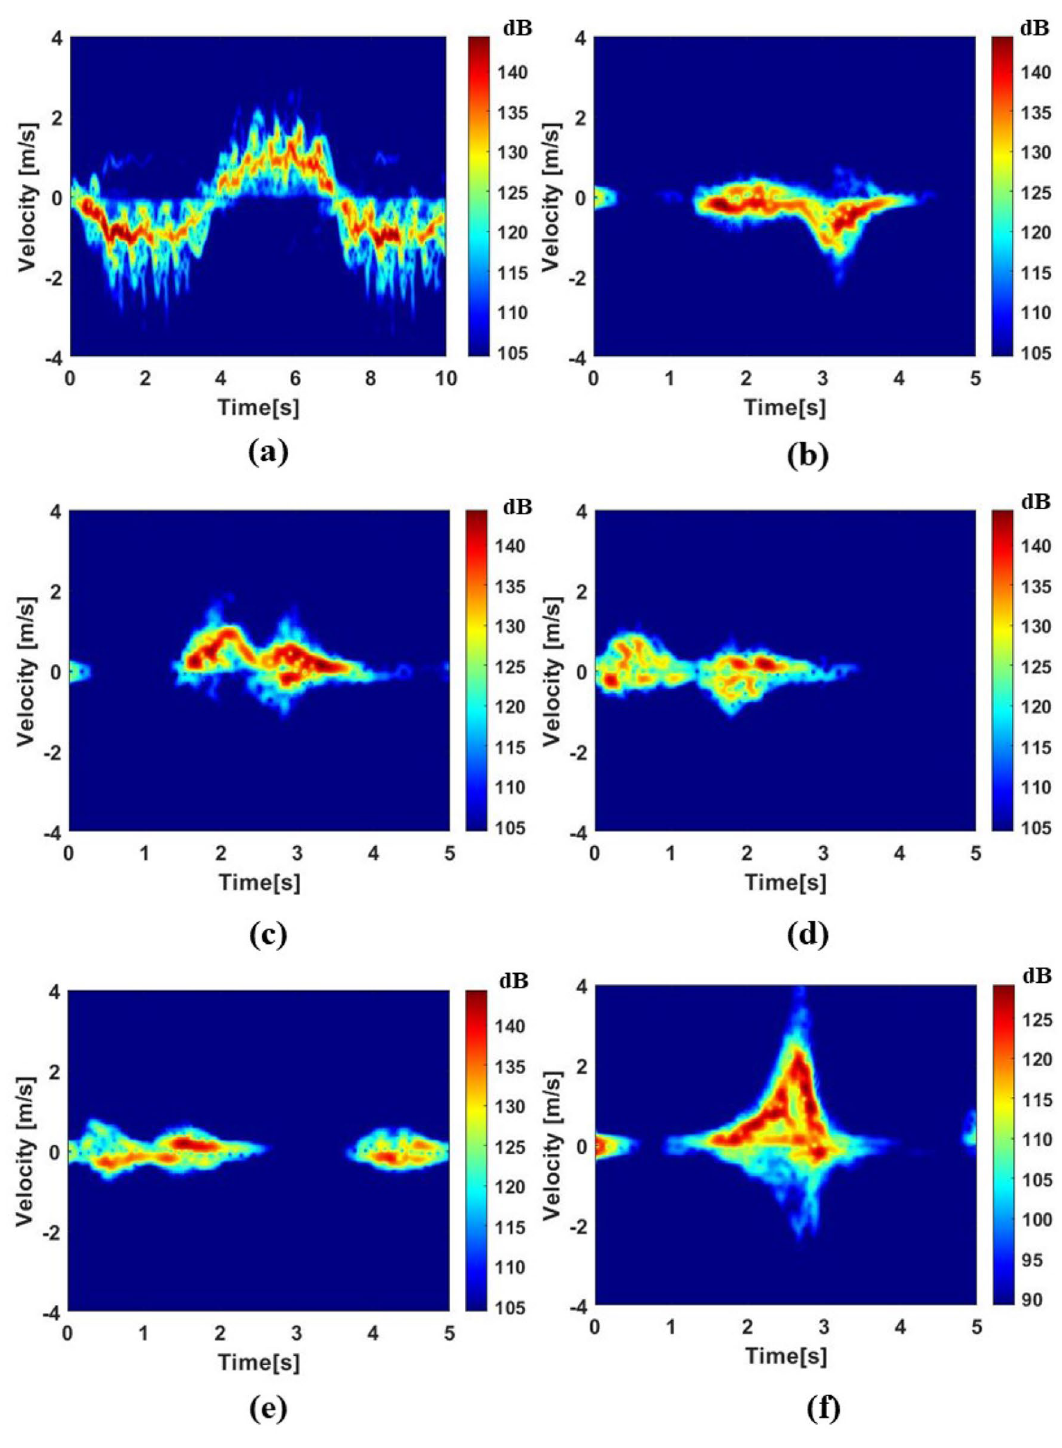
Figure 1. The micro-Doppler signatures of typical samples of the dataset. ( a – f ) represent activities A1 ~ A6 micro-Doppler